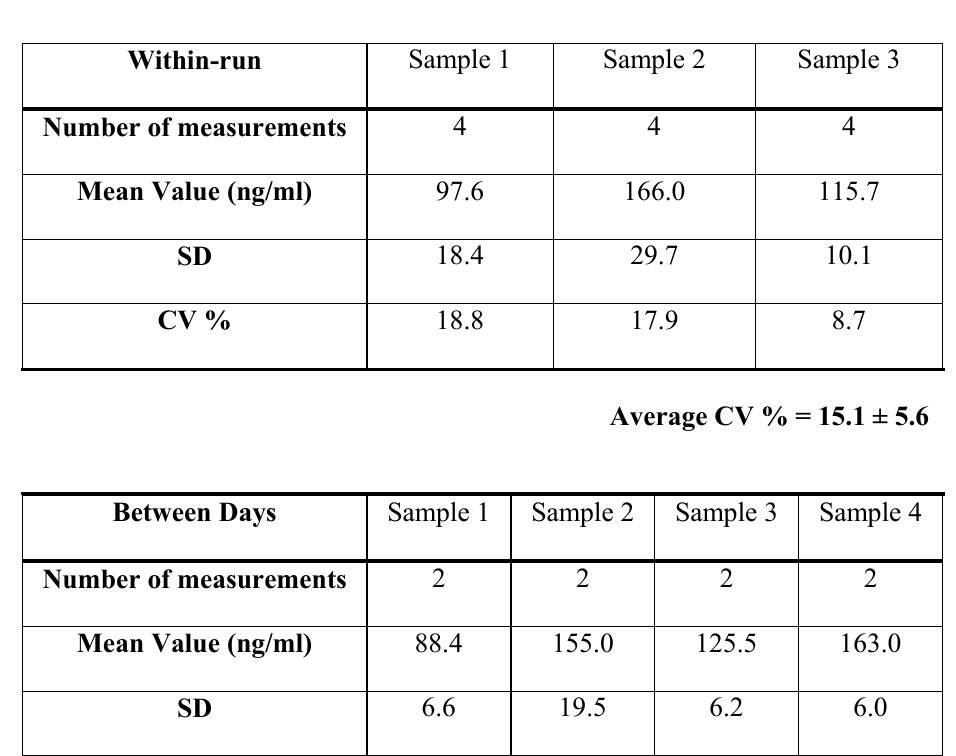
Table 2. Precision of the method, 3 specimens with different content of folinic acid were